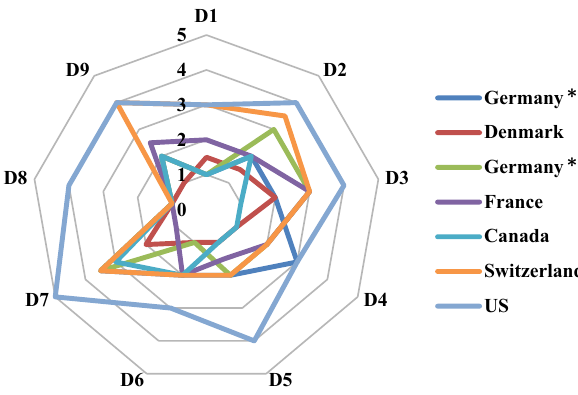
Fig. 3 Scores assigned by the participants for each difficulty abroad. *It should be noted that Germany appears twice because two participants (A and C) worked in this country